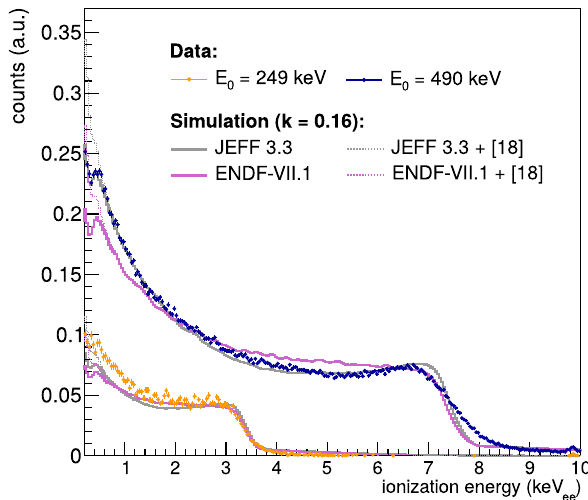
Fig. 15 Measured integrated nuclear recoil distribution for E n = 249keV (orange points) and E n = 490keV (blue points) and associated Geant4 simulations (solid lines) with JEFF 3.3 (gray) and ENDF- BVII.1 (purple). Superimposed are the simulations including the exten- sion of the quenching factor model found in [18] (dashed